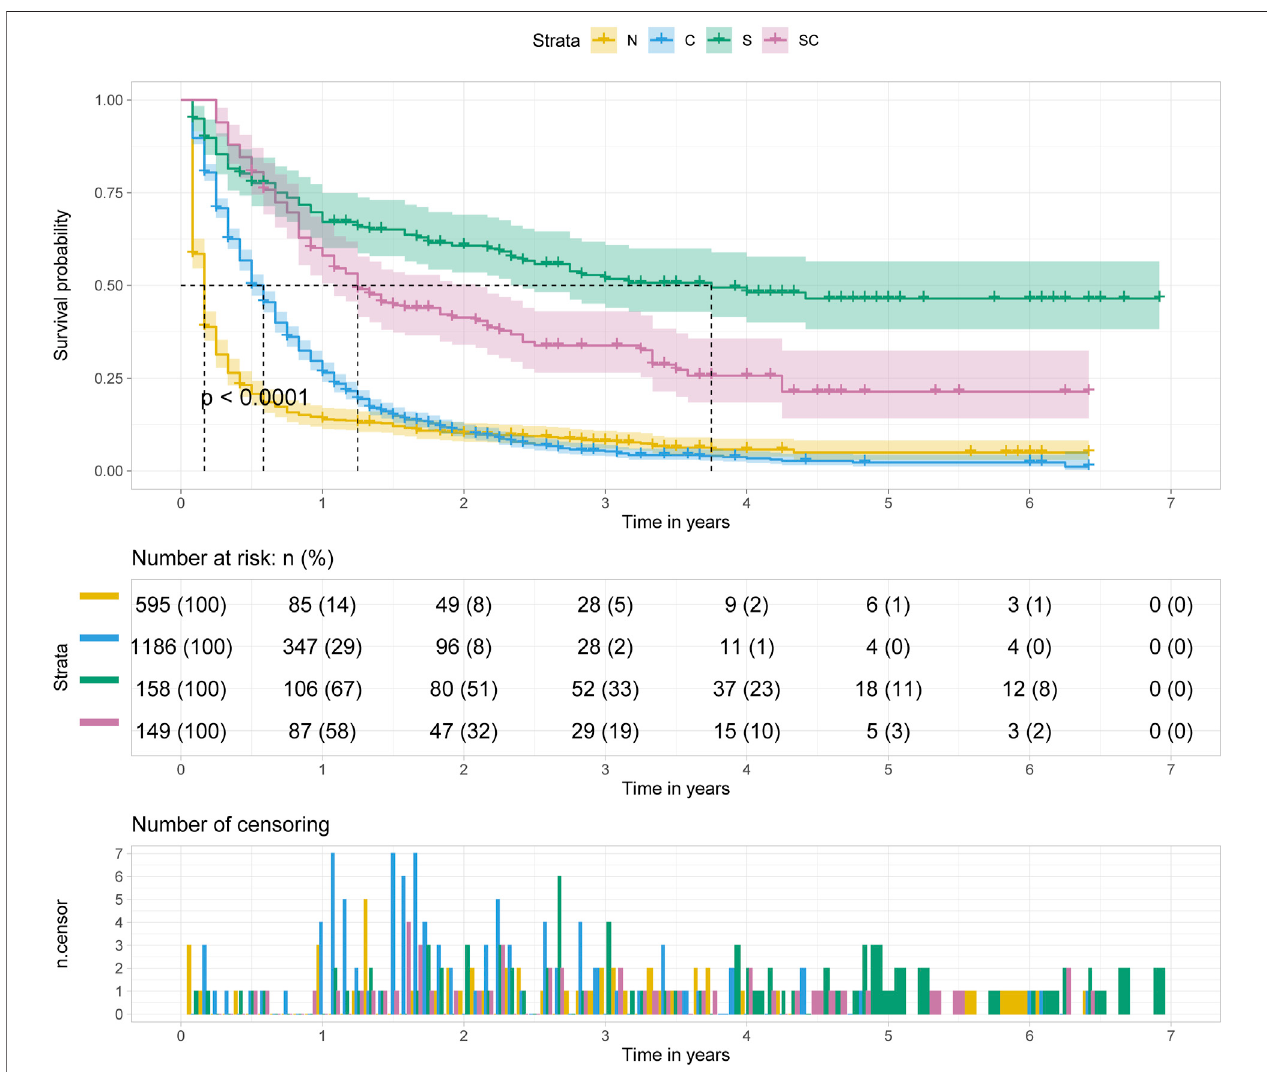
FIGURE 5 | Kalpan Meier survival curve showing the effect of treatment with pancreatic cancer metastasis to liver.